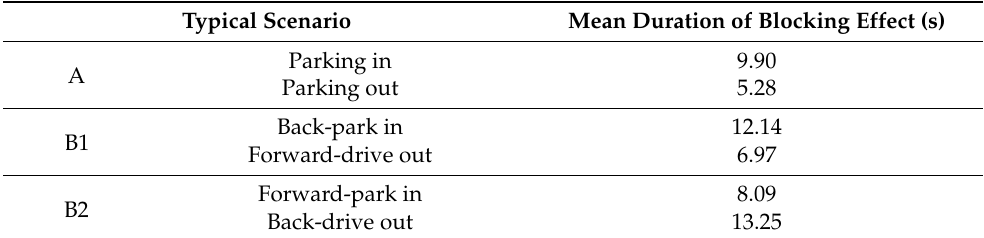
Table 5. Mean duration of blocking effect of typical roadside parking